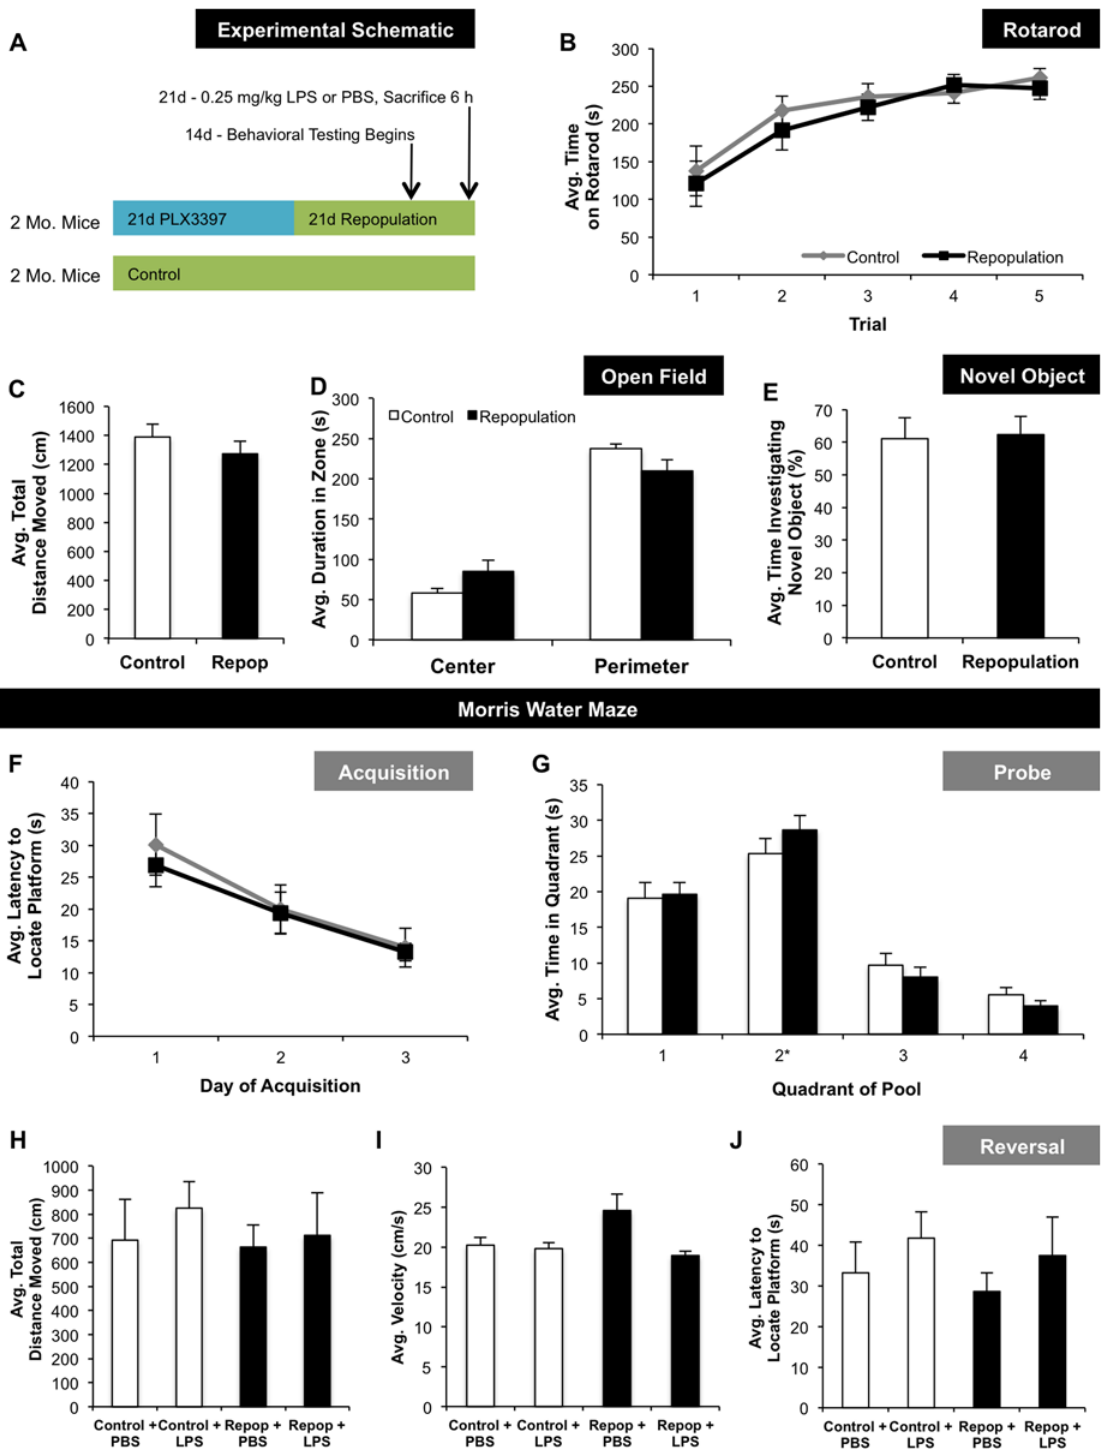
Fig 2. Impacts of Microglial Repopulation on Behavior, Cognition, and Motor Function. A) Schematic describing experimental design. Mice were administered either control diet (n = 10) or PLX3397 for 21 d to eliminate microglia, then the inhibitor was removed to allow microglial repopulation (n = 10). From days 14 to 21, behavioral testing was conducted. Mice were given an LPS challenge (0.25 mg/kg LPS or PBS, both administered IP) on the final day of behavioral testing and sacrificed 6 h later (n = 5 per group). B, C) No changes in motor function were observed, as indicated by time on rotarod and average distance moved in the open field, between control and microglia repopulated animals. D) There were no changes in anxiety between treatments, as